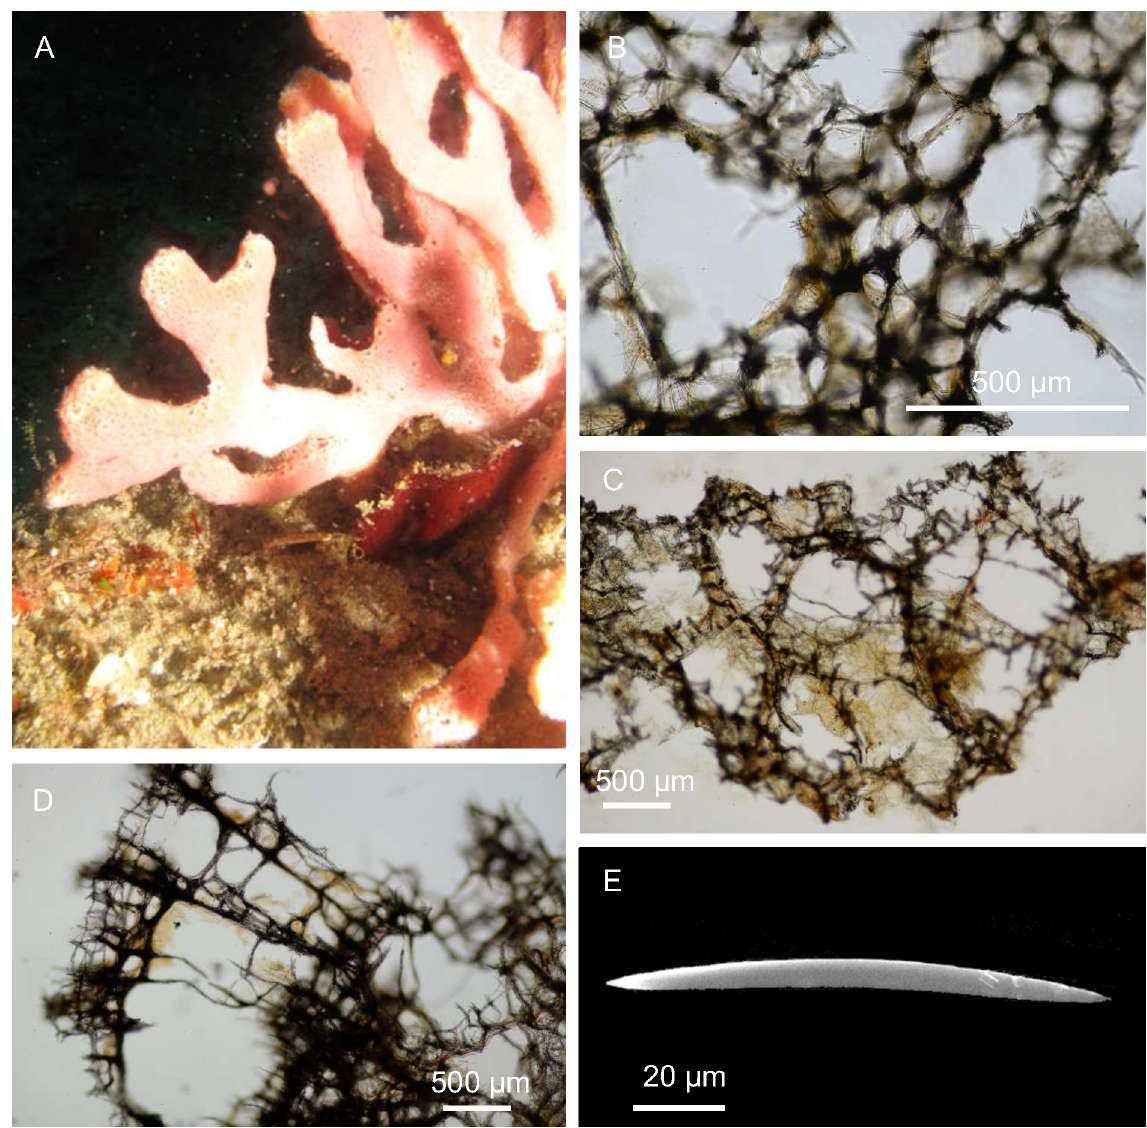
Fig. 10. Amphimedon palmata Calcinai & Belfiore sp. nov. A . The holotype MSNG 61504 in situ . B . Ectosomal skeleton. C . Ectosomal skeleton covered by a thin dermal membrane with scattered tangential oxeas. D . Choanosomal skeleton. E .